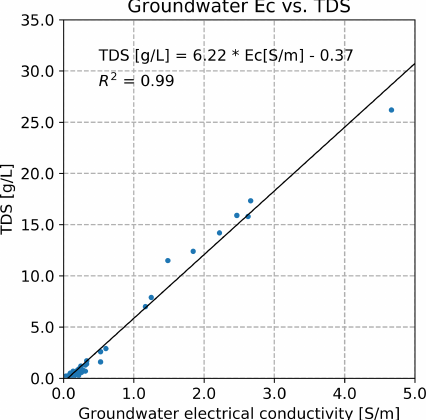
Figure 6. Linear regression between electrical conductivity of groundwater and